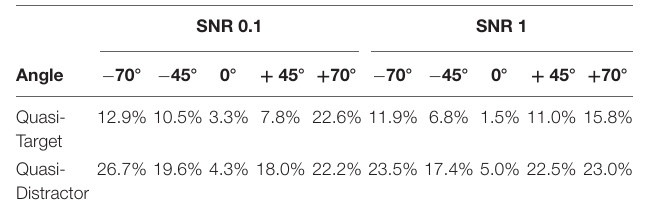
SNR = 0.1 and − 0.46 ◦ ± 0.04 at SNR = 1. In contrast, saccades are